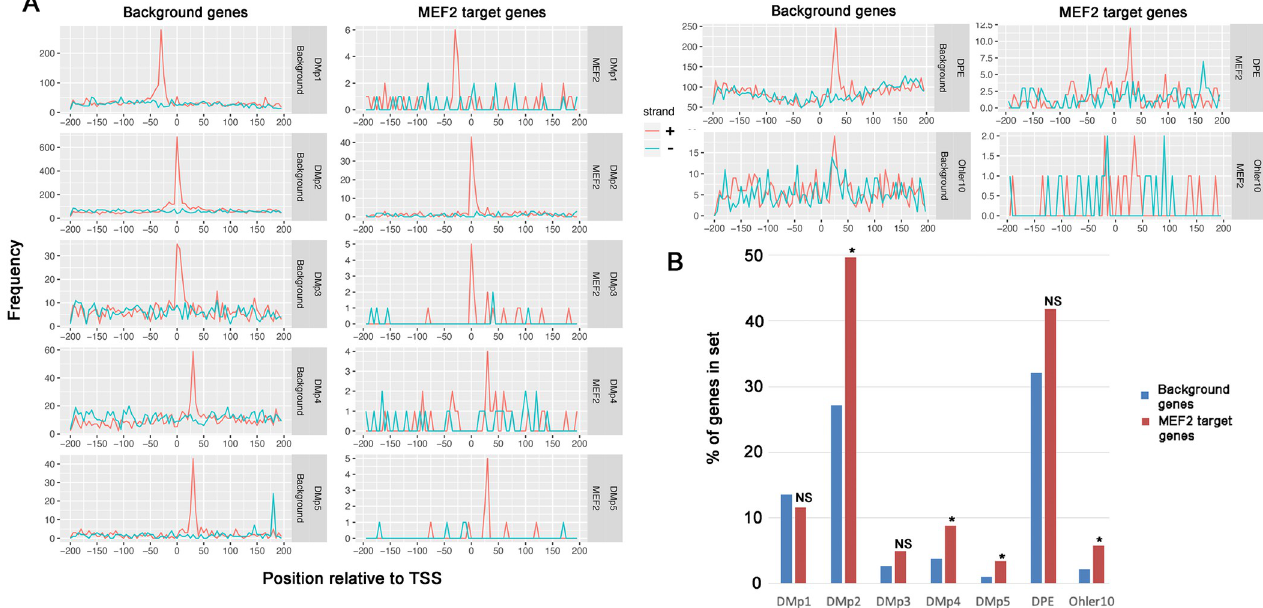
Fig 1. Occurrence of directional promoter motifs with precise locations (DMp) in control and MEF2 target genes. A: Frequency graphs showing the occurrence of each indicated motif in promoters from -200 to +200 relative to the transcription start site. Frequency data, representing the number of times that the element is detected at the indicated location, are shown separately for occurrences on the coding strand (+, red) versus the non-coding strand (-, blue). Graphs representing data from background genes are on the left of each pair of graphs, and data for MEF2 target genes are on the right of each pair. B: Relative frequencies of promoter elements in background and MEF2 datasets. NS, not significantly enriched in the MEF2 dataset; � , significantly P < 0.01) enriched in the MEF2 dataset.